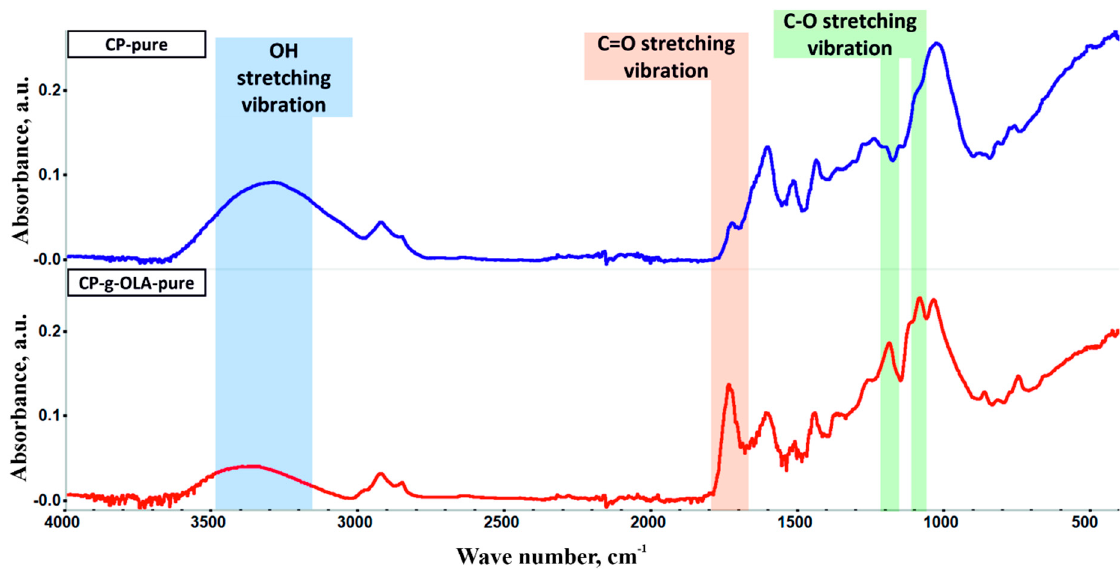
Figure 2. FTIR spectra of CP-pure and CP-g-OLA-pure.